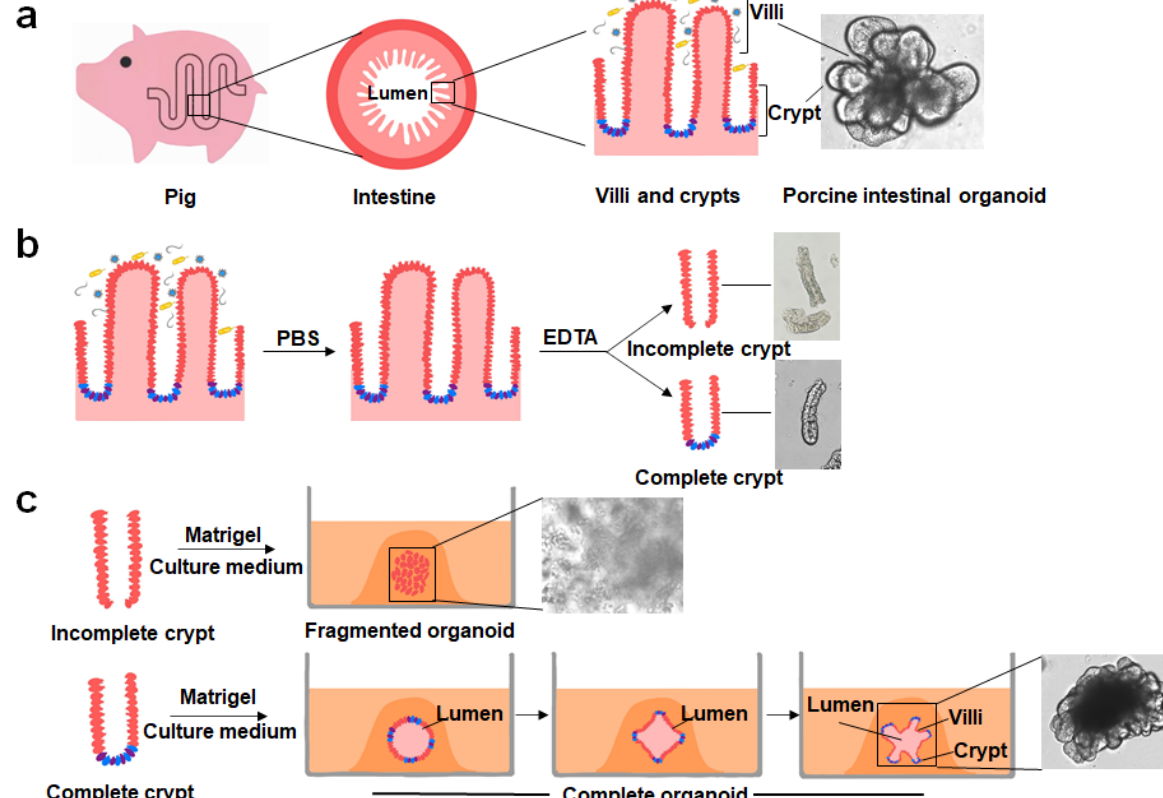
Figure 1. Intestinal structure, crypt location, and organoid formation. ( a ) The physiological and cross-sectional structure of the porcine intestine and the corresponding positions of intestinal villi and crypts in physiological states and porcine intestinal organoids. ( b , c ) Structure of complete intestinal crypts containing intestinal stem cells and Paneth cells at the base. The isolated crypts were embedded in Matrigel and then formedpetal-like intestinal organoids by adding various growth factors.